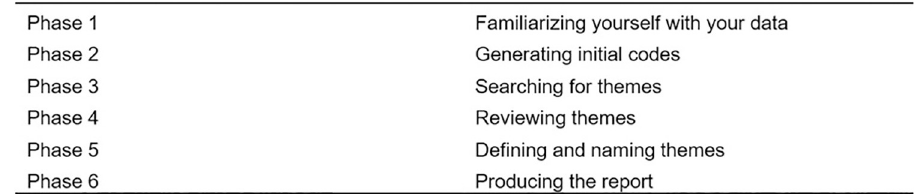
Fig 8. A step-by-step guide to thematic analysis as defined by Braun and Clarke [43].